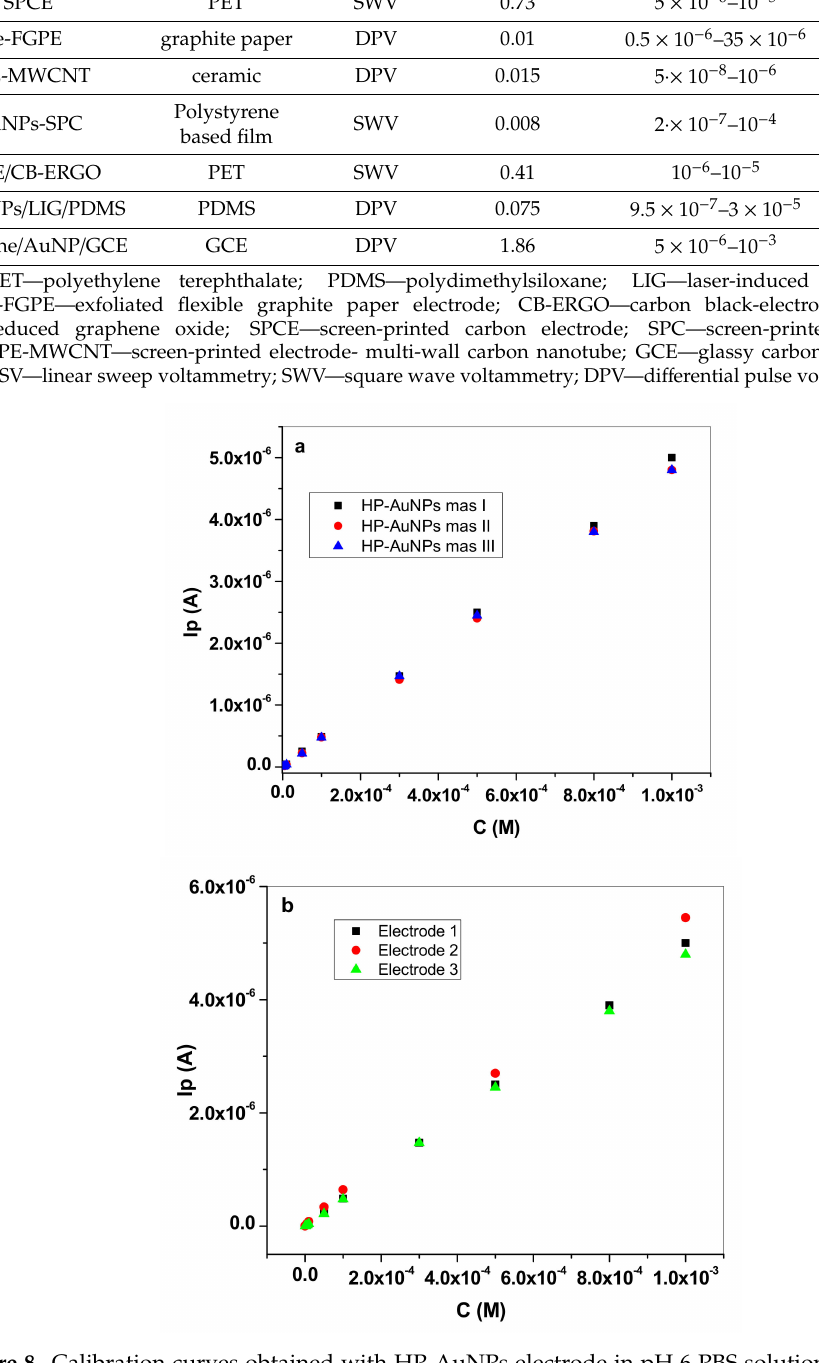
Figure 8. Calibration curves obtained with HP-AuNPs electrode in pH 6 PBS solutions containing di ff erent concentrations of dopamine (10 − 7 –10 − 3 M), for three consecutive measurements performed with the same ( a ) and di ff erent electrodes ( b